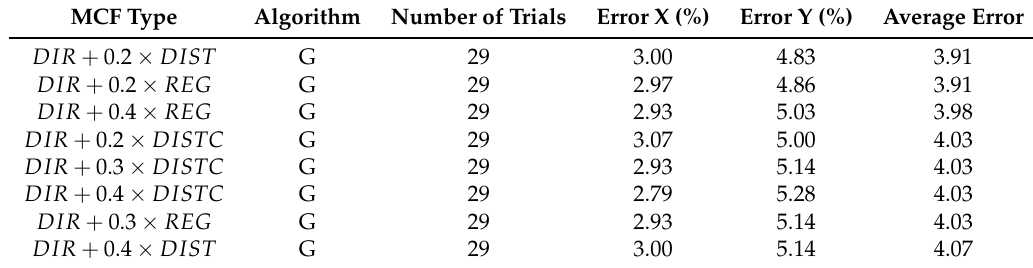
Table 10. Average errors for various fusions of MCFs, saliency EXP and removalPercent = 20. Only the best achieved fusions are presented.